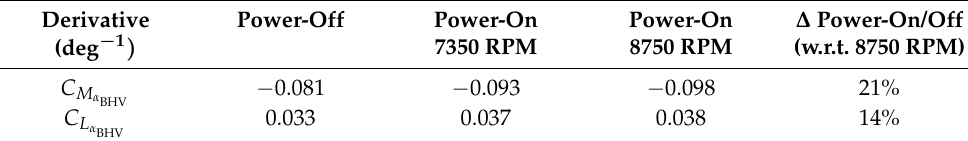
Table 6. Global (direct and indirect) propulsive effects on lift and pitching moment coefficient curve slope, BHV aircraft configuration, Re = 315,000, CG at LE